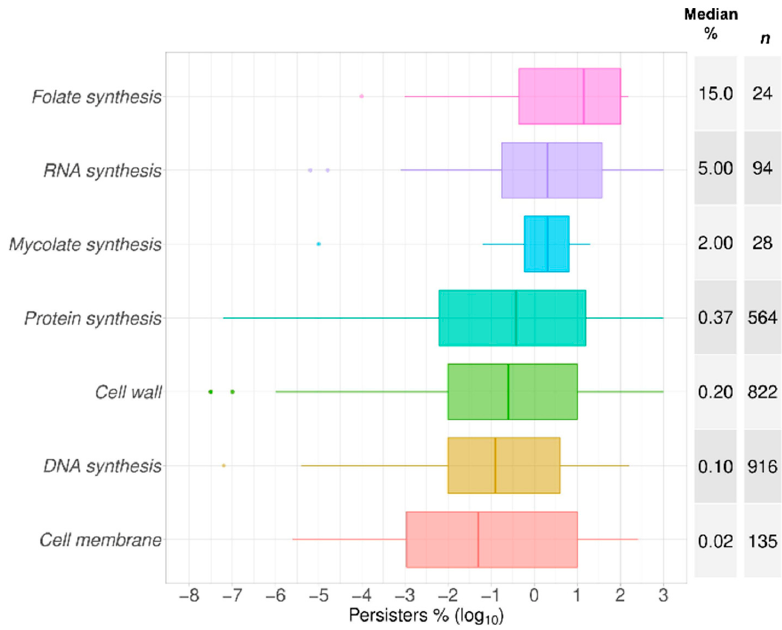
Figure 5. Bacterial persisters compared by antibiotic mechanism of action. Antibiotics were separated in 7 groups according to their main mechanism of action or target (Table 2). These groups were listed in the order of the median value as plotted as box plots of the percentage of cells surviving the exposure to each of these antibiotics in comparison to time zero in time–kill assays, or in comparison to the control without antibiotics in one-time-point experiments. The abscissa represents the spread of the data as log 10 values of the percentage of persisters. The median value for the percentage of surviving cells is listed in the median % column followed by the total number of time points collected for each species ( n ).